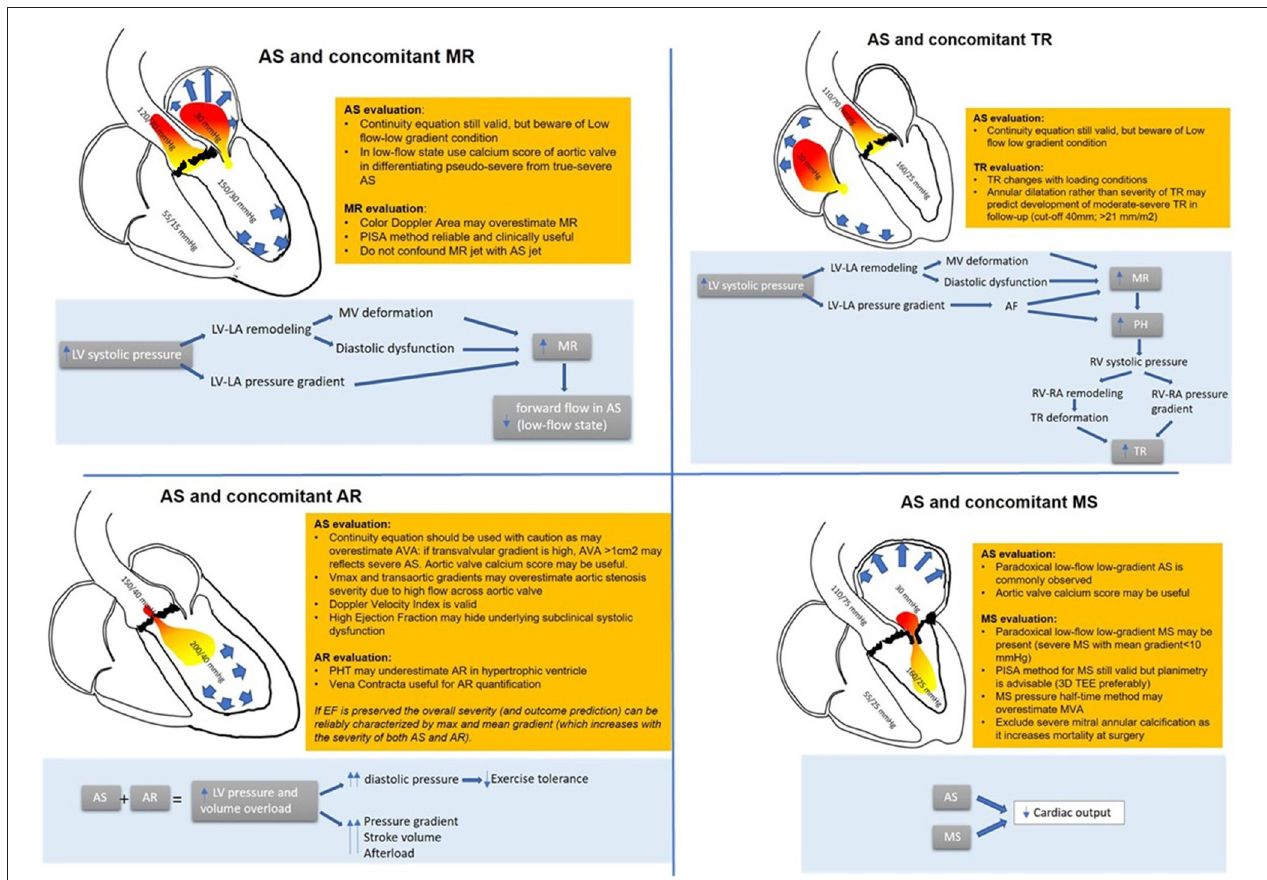
FIGURE 1 | Combination of AS and other valvular heart disease: hemodynamic interactions and diagnostic pitfalls and